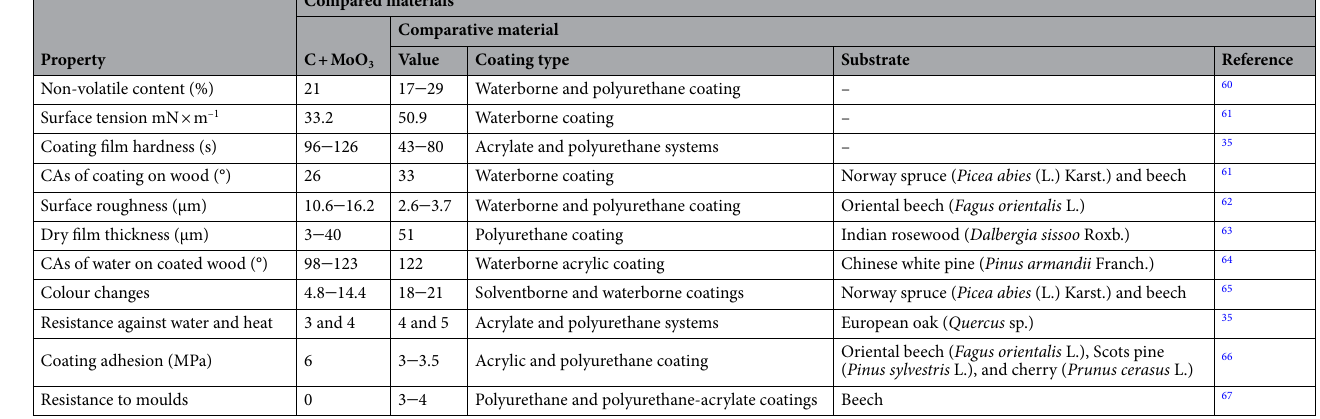
Table 5. The overview of results gained in this study and their comparison with the